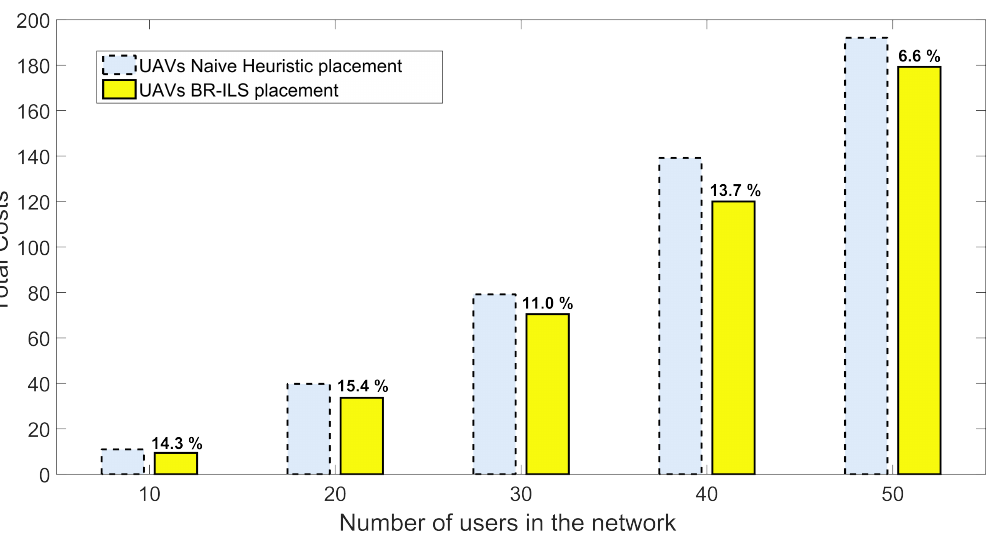
Figure 3. Comparison between the total cost (inverse link capacity) obtained with a Naive heuristic versus the total cost resulting from the application of the proposed BR-ILS